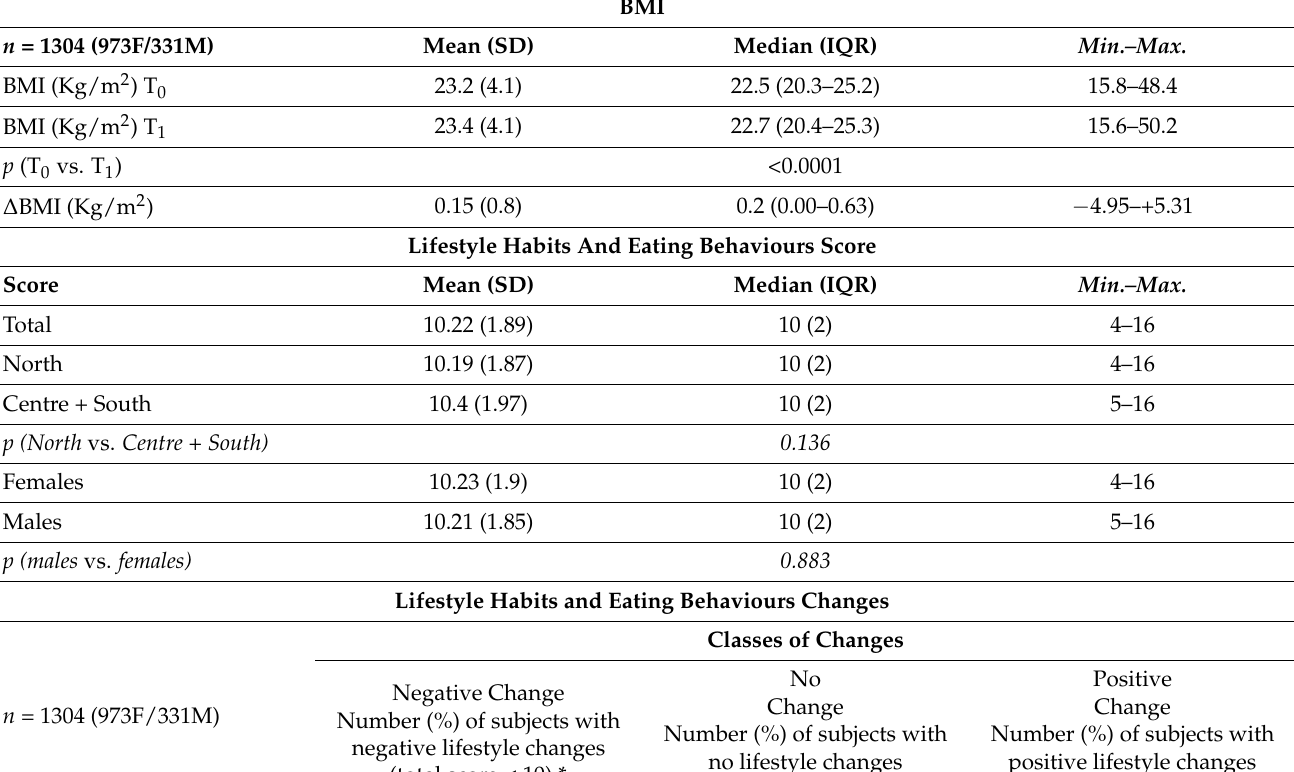
Table 1. Description of BMI, lifestyle habits and eating behaviors during COVID-19 pandemic “Phase 1”. For BMI, lifestyle habits and eating behaviors score, data are described as mean (standard deviation, SD), median (InterQuartile Range, IQR) and minimum (min.) and maximum (max.) value. For lifestyle habits and eating behaviors changes, data are described as absolute number (n) and relative frequency (%) of subjects who changed their lifestyle habits and eating